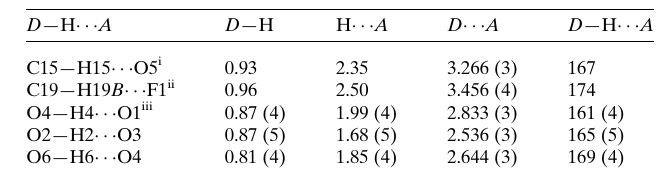
Table 1 Hydrogen-bond geometry (A˚ , (cid:3) ).